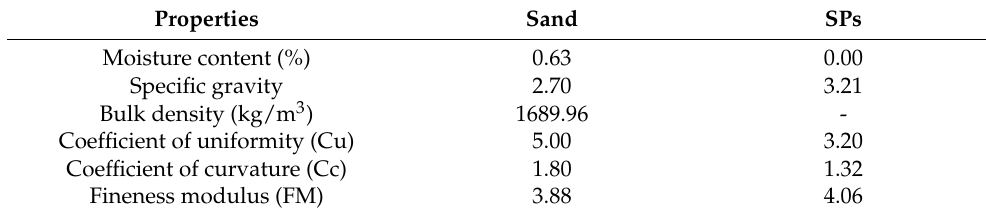
Table 3. Physical properties of aggregates.